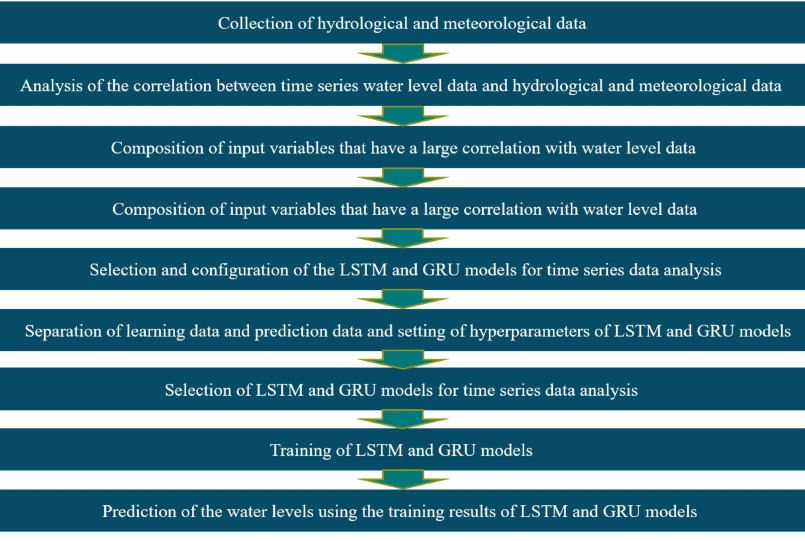
Figure 3. Flowchart on learning and prediction of water-level data, using LSTM and GRU